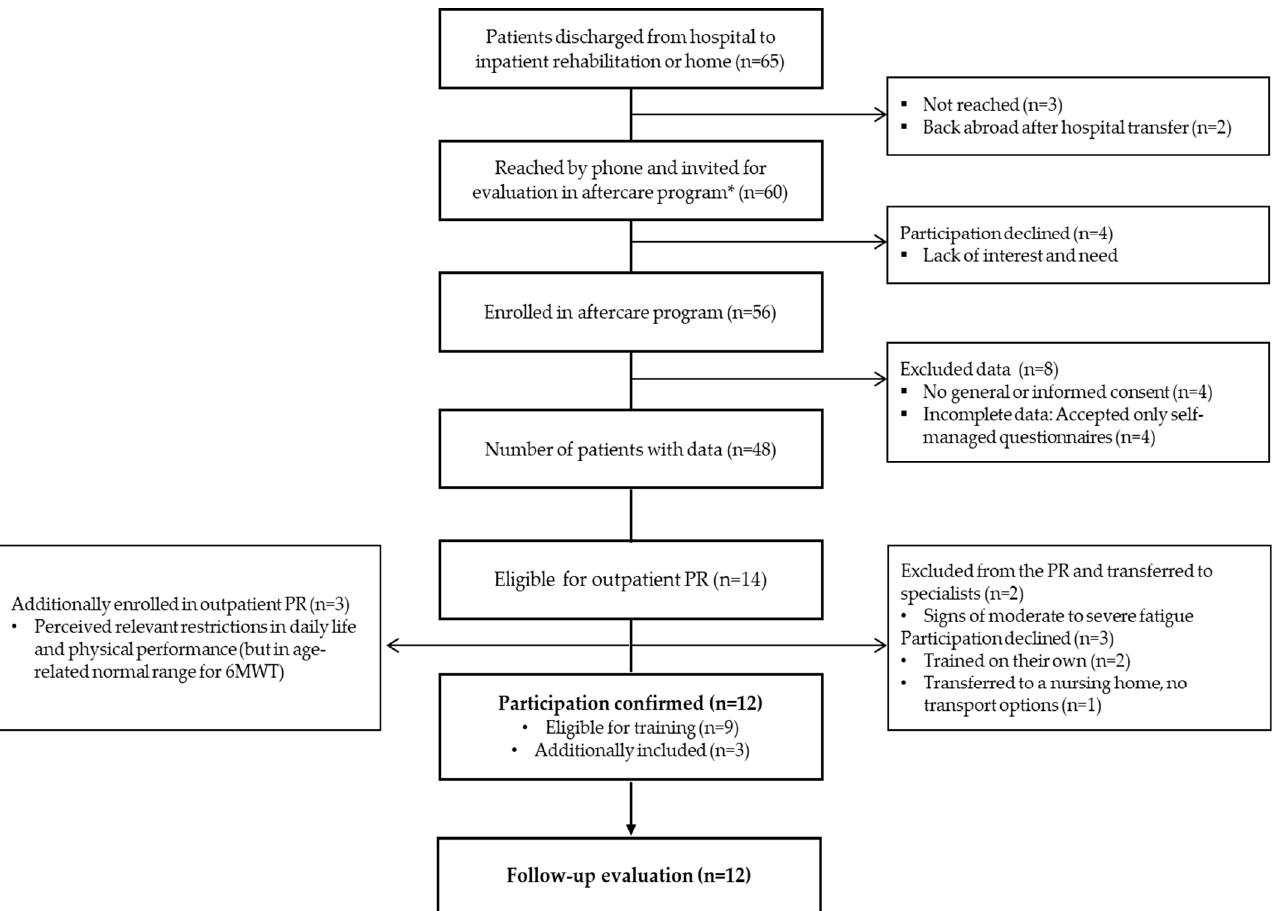
Figure 1. Flow-chart of patient recruitment. PR = pulmonary rehabilitation; * aftercare program = a standard follow-up program developed independently of the research and included testing and counseling of patients post-COVID-19 primarily by specialized physiotherapists and pulmonologists.